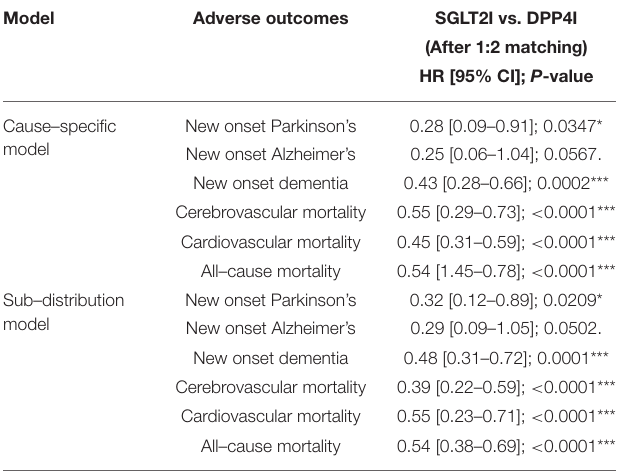
TABLE 3 | HRs (and 95% CIs) of SGLT2I vs. DPP4I from cause–specific and subdistribution hazard models for cognitive dysfunction and mortality risks after 1:2 propensity score matching.